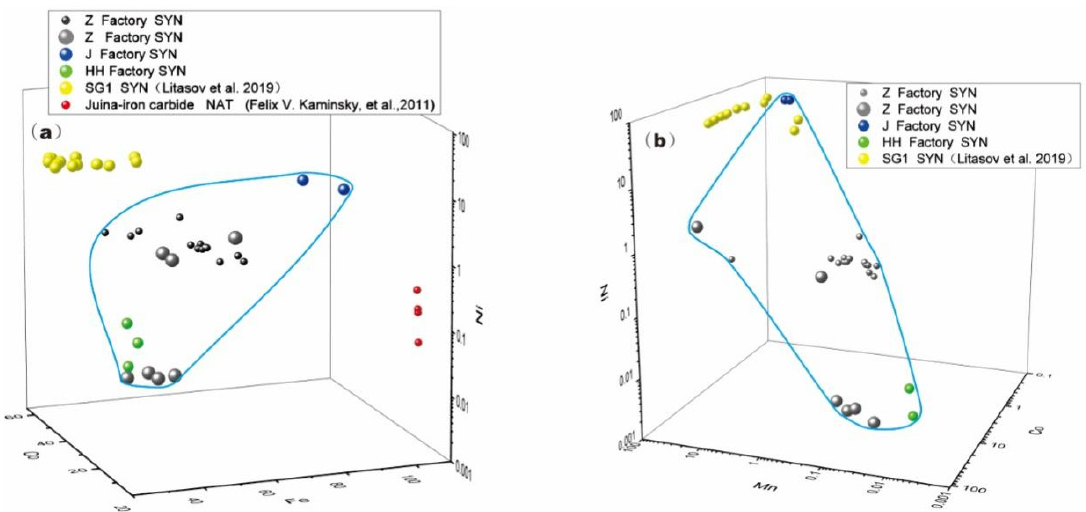
Figure 7. ( a ) Fe–Co–Ni, ( b ) Co–Mn–Ni elements plots in inclusions of diamonds, data did normalization operation. Sample numbers are HH-5, HH-20, Z-1, Z-3, J-3 in this study; SG1 are yellow abrasive diamonds, data from Litasov et al. [24]; Julia-iron carbide is a natural super deep diamond, data from Kaminsky et al. [15]; SYN- Synthetic diamond, NAT- Natural diamond; colorless HPHT dia-